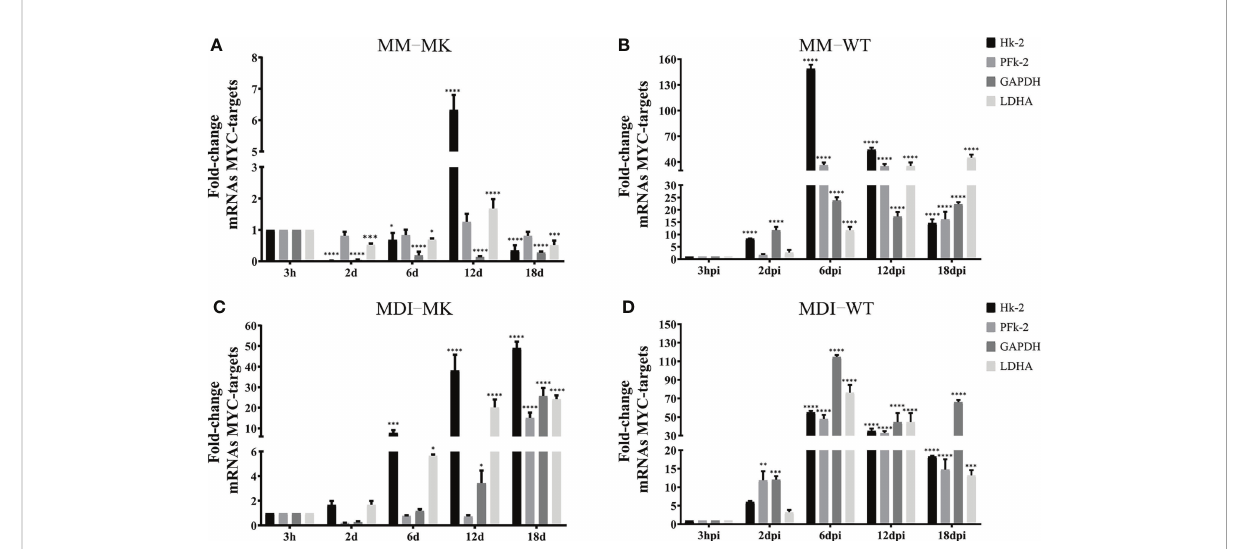
FIGURE 7 HAdV-D36 infection of adipocyte committed cells promotes the expression of MYC- glycolytic target genes. To determine the effect of infection on MYC-target genes, 3T3-L1 cells at 12dpc were HAdV-D36-infected (B, D) or mock-infected (A, C) , without adipocyte differentiation inducers (MM) (A, B) or with (MDI) (C, D) . RNA was isolated at the indicated time-points and the expression levels of hexokinase (Hk), phosphofructokinase (PFk), glyceraldehyde-3-phosphate dehydrogenase (GAPDH) and Lactate dehydrogenase (LDHA) were measured by RT- qPCR. All values represent the mean of two independent experiments, measured in technical duplicates. Data are expressed as the mean and error bars represent standard deviations. Signi fi cant differences from each time-point relative to 3h are indicated by *p < 0,05. **p < 0,005. ***p < 0,0005. ****p < 0,00001. ns, not signi fi